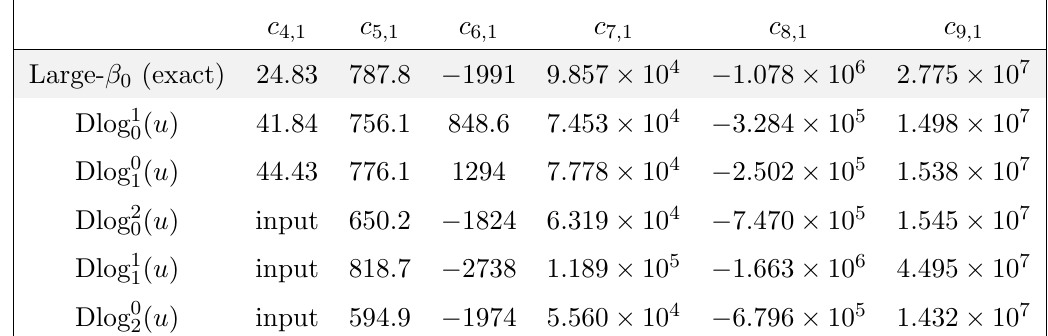
Table 3. Adler function coe(cid:14)cients extracted from D-Log Pad(cid:19)e approximants, Dlog N structed to B [ (cid:14) (0) ]( u ) in the large- (cid:12) 0 limit.